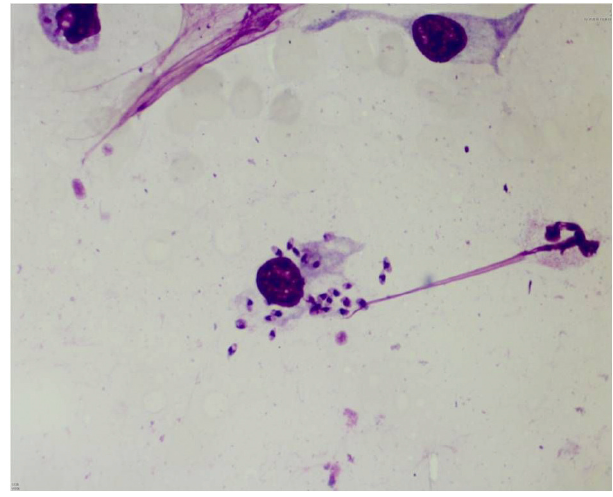
Figure 2. Leishmania spp. amastigotes (Giemsa staining